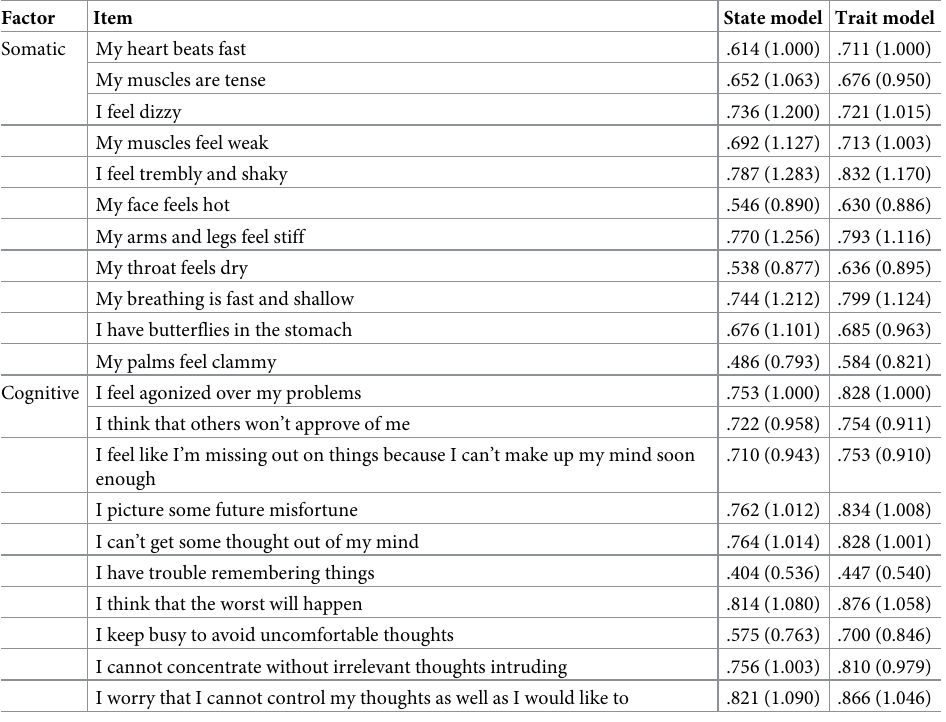
Table 3. Standardized (Unstardardized) factor loadings: State and trait models of STICSA (MS2 and